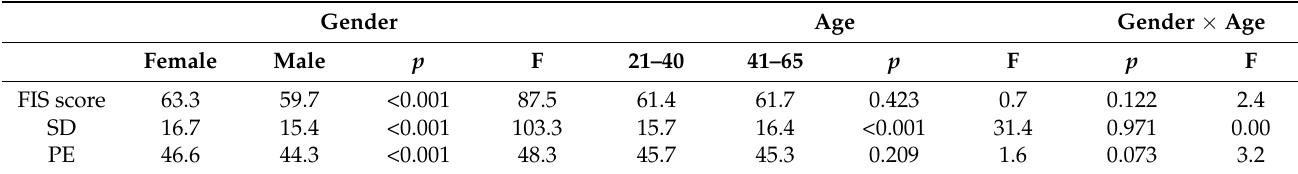
Table 2. Two-way ANOVA model on FIS score, SD score, and PE score with an interaction (fixed factors: gender and age) for the whole population considered. The FIS scale ranged from 12 to 84. Gender Age Gender ×